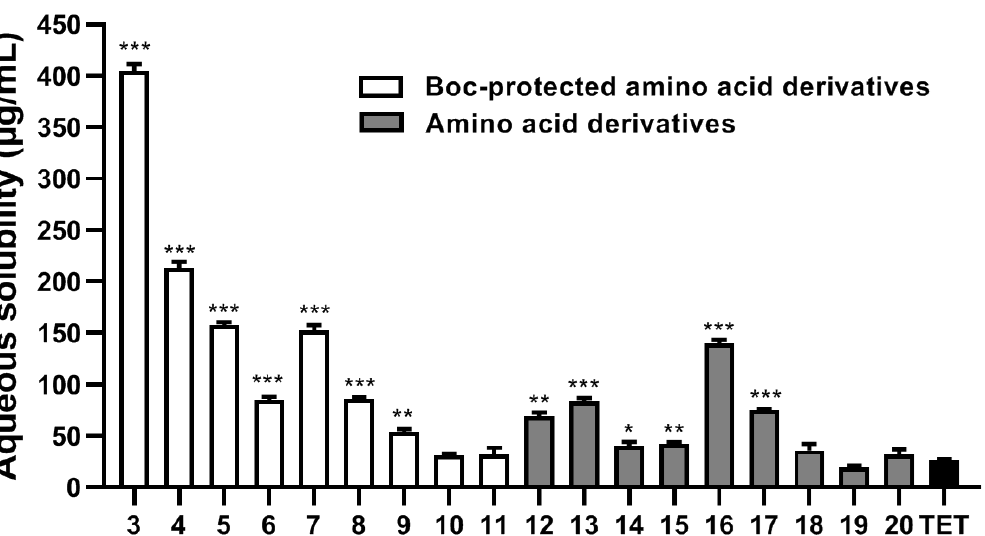
Figure 2. Aqueous solubility analysis of TET derivatives in neutral water. *: p < 0.05, **: p < 0.01, ***: p < 0.001 vs. TET.